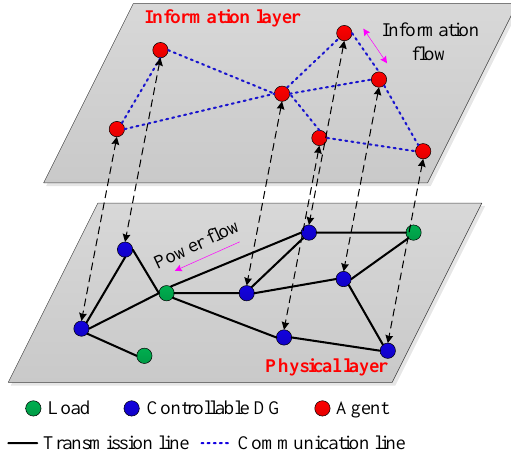
Figure 1. The two-layer model of an islanded